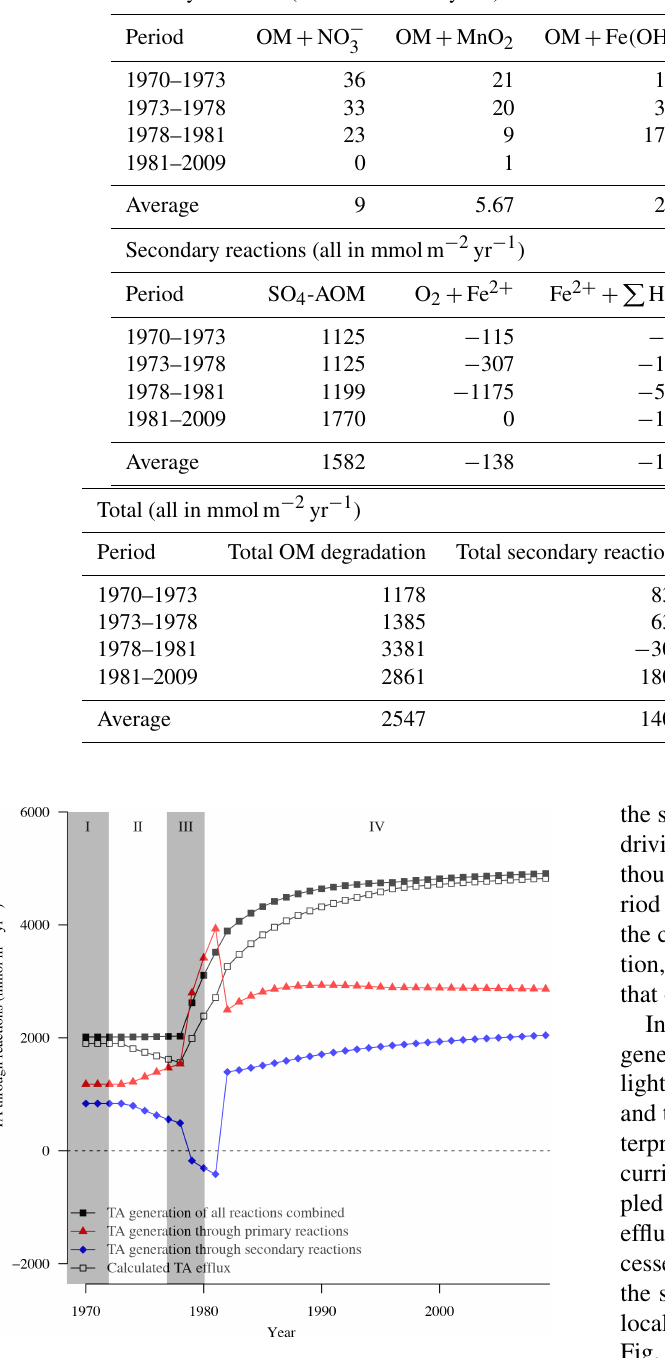
Figure 4. Calculated TA efflux and generation at site F80 integrated over the whole sediment column (all in mmolm − 2 yr − 1 ) due to var- ious biogeochemical processes implemented in the